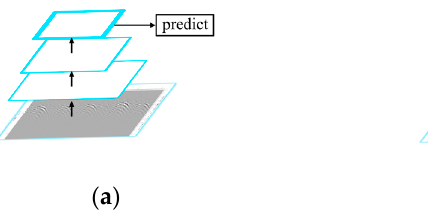
Figure 10. FPN + PANet structure. However, PANet is only a simple two-way fusion. Since different input features have different resolutions, their contributions to output features are usually unequal. In addi- tion, when PANet performs feature fusion, it only adds different input features directly, which will lead to unbalanced output features, as shown in Figure 11a.